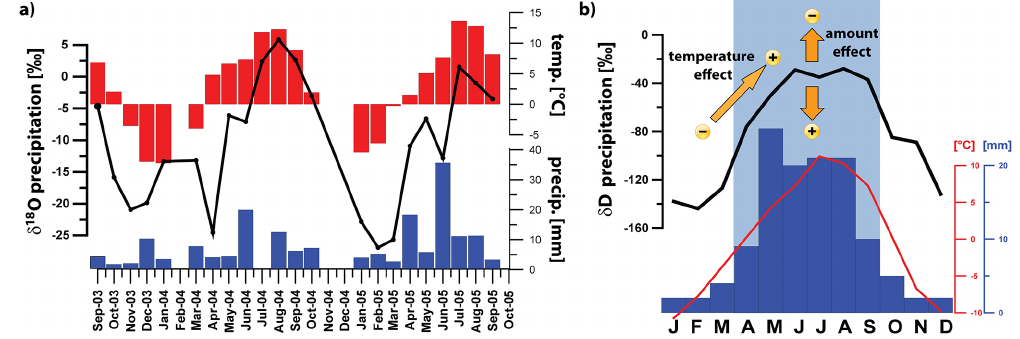
Figure 4. (a) Monthly isotopic and climate data from Taxkorgan climate station (Yao et al., 2013), located ca. 80km south of Lake Karakuli (altitude ca. 3100m). (b) Average monthly climate (Miehe et al., 2001) and isotopic (OIPC; Bowen and Revenaugh, 2003) data from Bulun Kul climate station, located ca. 30km northeast of Lake Karakuli (altitude ca. 3300m). Shaded area indicates summer, i.e. wet